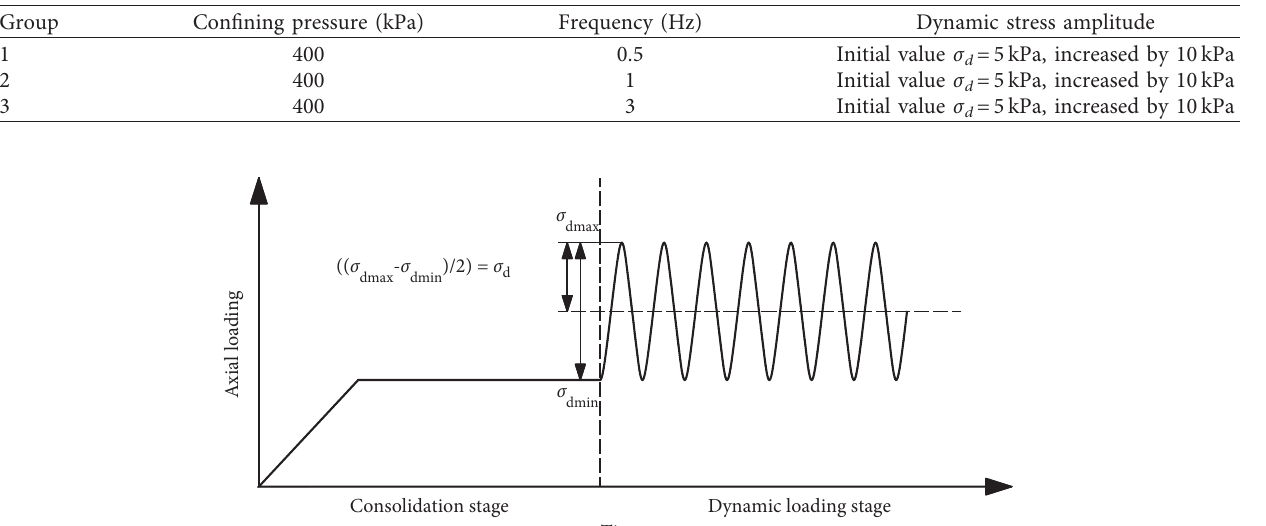
Figure 3: Schematic of triaxial cyclic loading. Note that σ d max denotes the maximum dynamic stress, σ d min denotes the minimum dynamic stress, and σ d denotes the dynamic amplitude.